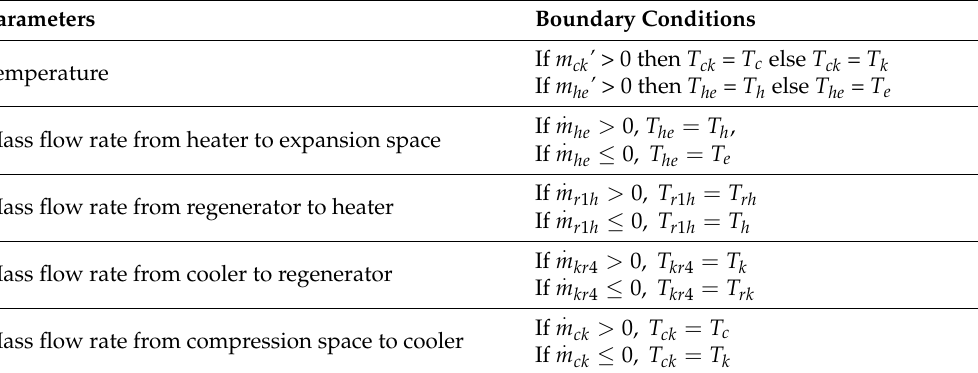
Table 2. Boundary